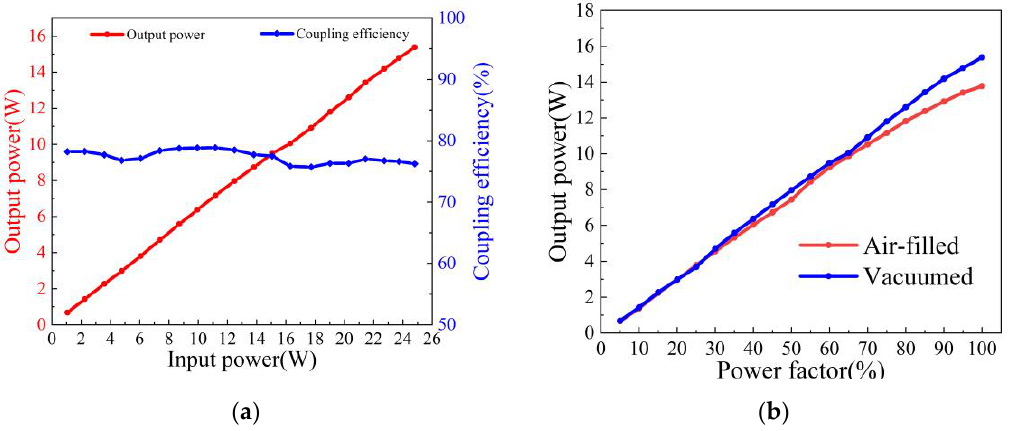
Figure 5. ( a ) Vacuumed AR-HCF output power and coupling efficiency as a function of incident power and ( b ) Comparison of output power between 5 m air-filled and vacuumed AR-HCF.